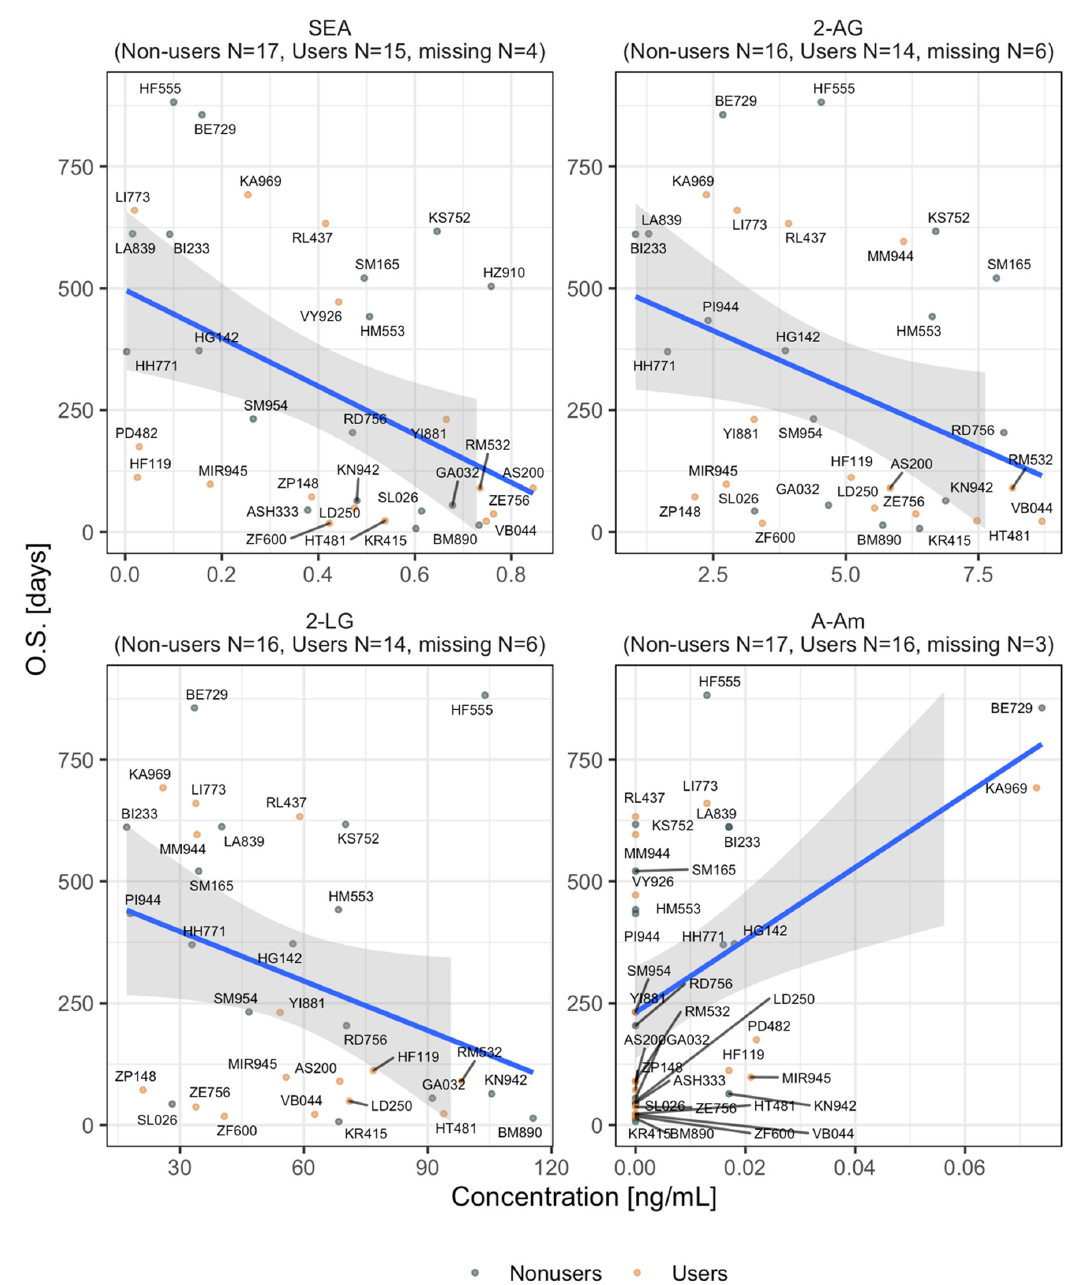
Figure 4. Correlation between eCB concentrations (ng / mL) and overall survival time (OS) measured at time zero (before immunotherapy initiation). Each panel represents a di ff erent eCB. Each data point represents a patient with the corresponding anonymized identification number. The blue line indicates the linear trend across the data points. The trends were fitted by means of linear regressions with Gaussian kernel. N -arachidonoyl amide (A-Am) includes two extreme values that were considered feasible measurements to be included. The shaded areas indicate a 95% confidence interval of the OS trend. Nonshaded segments indicate that the confidence interval was outside the limits of the y-axis. R 2 / R 2 adjusted parameters are, respectively: N -stearoyl ethanolamide (SEA) = 0.220 / 0.196, 2-arachidonoylglycerol (2-AG) = 0.139 / 0.110, 2-linoleoyl glycerol (2-LG) = 0.110 / 0.080, and A-Am = 0.234 / 0.211. Estimated p -values for the slopes were, respectively: SEA = 0.005, 2-AG = 0.036, 2-LG = 0.064, and A-Am = 0.003. All slopes’ estimate p-values were significant at a 0.1 level, indicating significant variations in OS-time per unit change of patients’ serum eCB concentrations at the